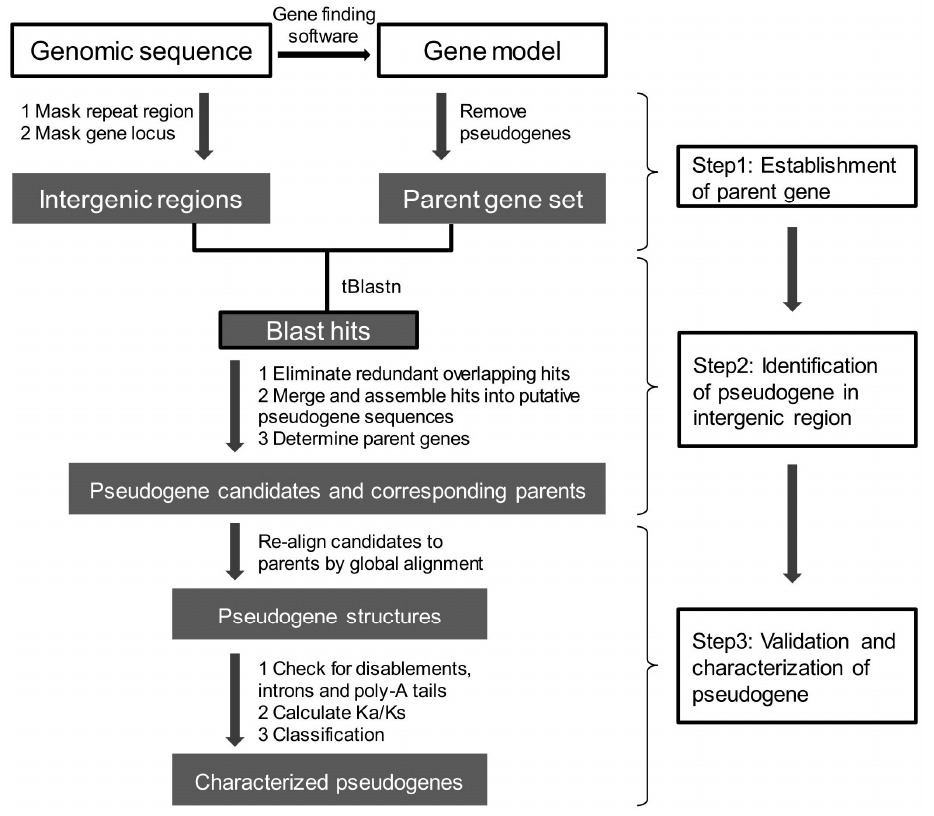
Figure 3. A flow chart of genome-wide pseudogene prediction methods.